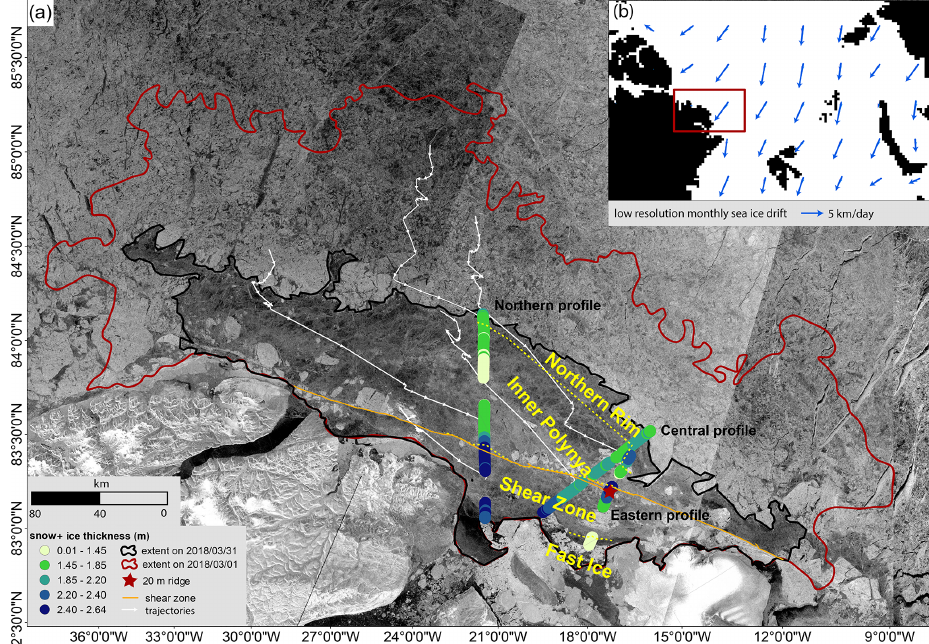
Figure 1. Ice thickness survey of the first-year ice (FYI) in the refrozen polynya off the coast of North Greenland in March 2018. (a) Sentinel-1 SAR Extra Wide Swath HH-polarization image acquired on 31 March 2018, shown on a decibel scale. The dark-gray areas are heavily deformed FYI between brighter multi-year ice (MYI) (upper image part and embedded in the FYI) and the coast of Greenland (lower part). Red and black lines outline the extents of the refrozen polynya on 1 and 31 March 2018. A sequence of white arrows illustrates four ice drift trajectories derived from daily velocity fields (Sect. 2.5), representing the typical southeasterly ice movement during the convergent closing of the polynya. The orange line marks the large-scale shear zone, and the red star marks the location of a 20m thick ridge. Colored circles represent the 15km running mean of the FYI snow and ice thicknesses. We chose the non-linear color scale to stress the differences in mean thickness between 1.4 and 2.4m (see Table 1). Dashed yellow lines show four distinct zones with different mean thicknesses and deformation histories: thin ice in the weakly deformed Fast Ice; thick ice in the severely deformed Shear Zone; moderately deformed, thin ice in the Inner Polynya; and strongly deformed, thick ice in the Northern Rim. (b) Overview map with monthly averaged, low-resolution sea ice drift in March 2018 (not showing the local drift variability in the polynya, drift from NSIDC Polar Pathfinder; for details, see “Data availability” at the end of the text). The red box marks the region shown in (a)